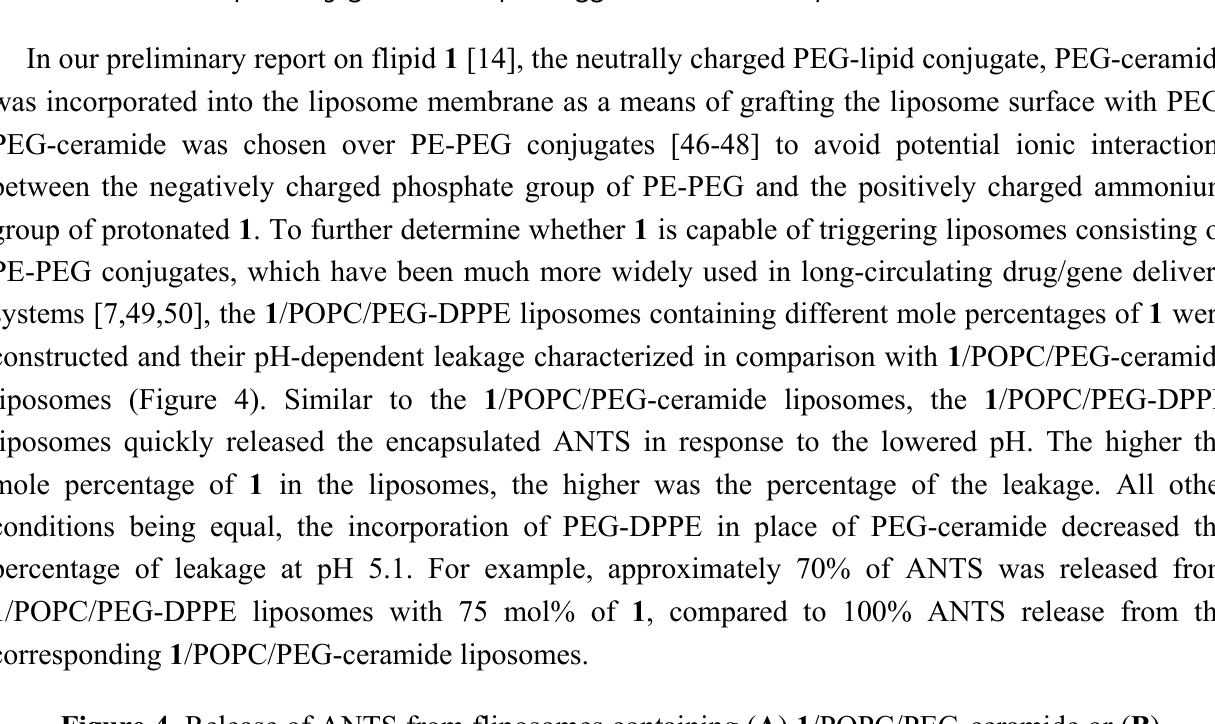
Figure 4. Release of ANTS from fliposomes containing ( A ) 1 /POPC/PEG-ceramide or ( B ) 1 /POPC/PEG-DPPE upon lowering pH from 7.4 to 5.1 (arrows). The x -axes are in relative time scales to fit all the traces into the